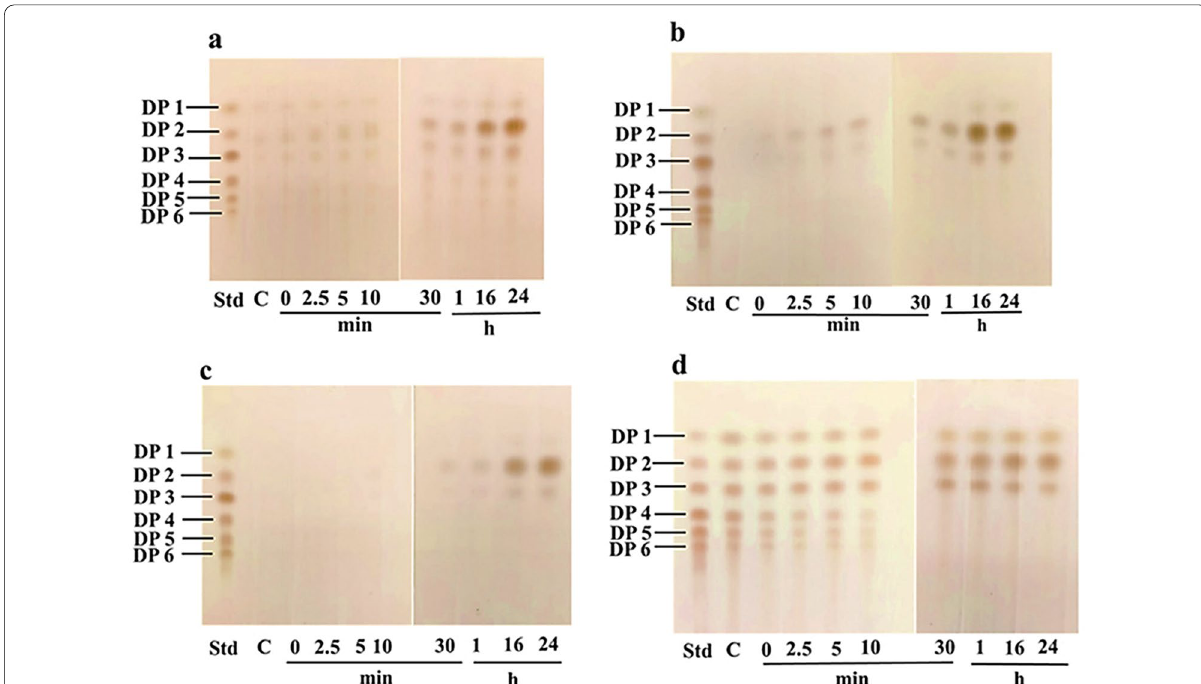
Fig. 2 Time-course of hydrolysis of various types of chitins by Vh ChiA. a β-chitin (squid pen), b α-chitin (shrimp shell), c α-chitin (crab shell) and d crude chitooligosaccharide mixture. Small aliquots of the reaction sample from time points 0, 2.5, 5, 10, 30 min and 1,16, 24 h were analyzed by TLC. Each reaction mix contained 5 mg (dry weight) of different colloidal chitins in 0.1 M sodium acetate buffer pH 5.5 and 100 U of Vh ChiA. The control was substrate alone. Std represents a mixture of (GlcNAc) 1–6 (labeled DP1–DP6), migrating alongside the reaction samples. Control lanes (C) contained the substrate but no